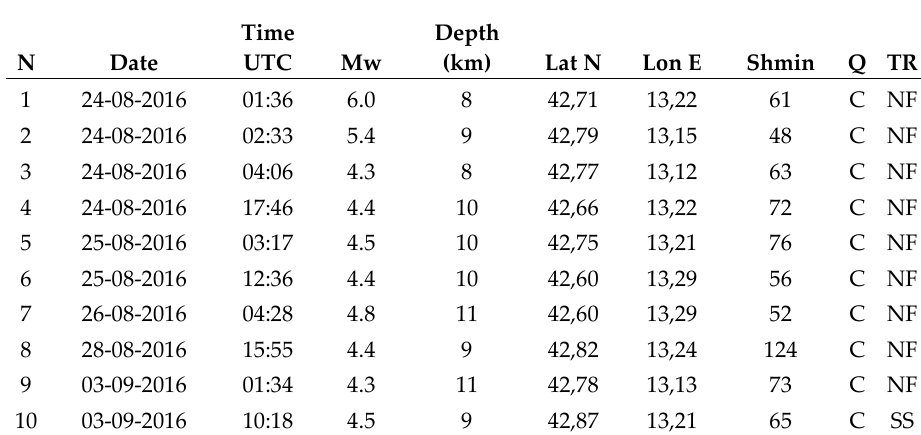
Table 1. Earthquake focal mechanism data